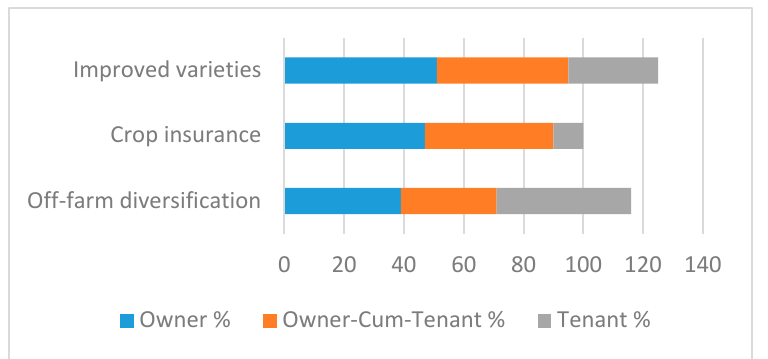
Figure 4. Risk management by land tenancy.